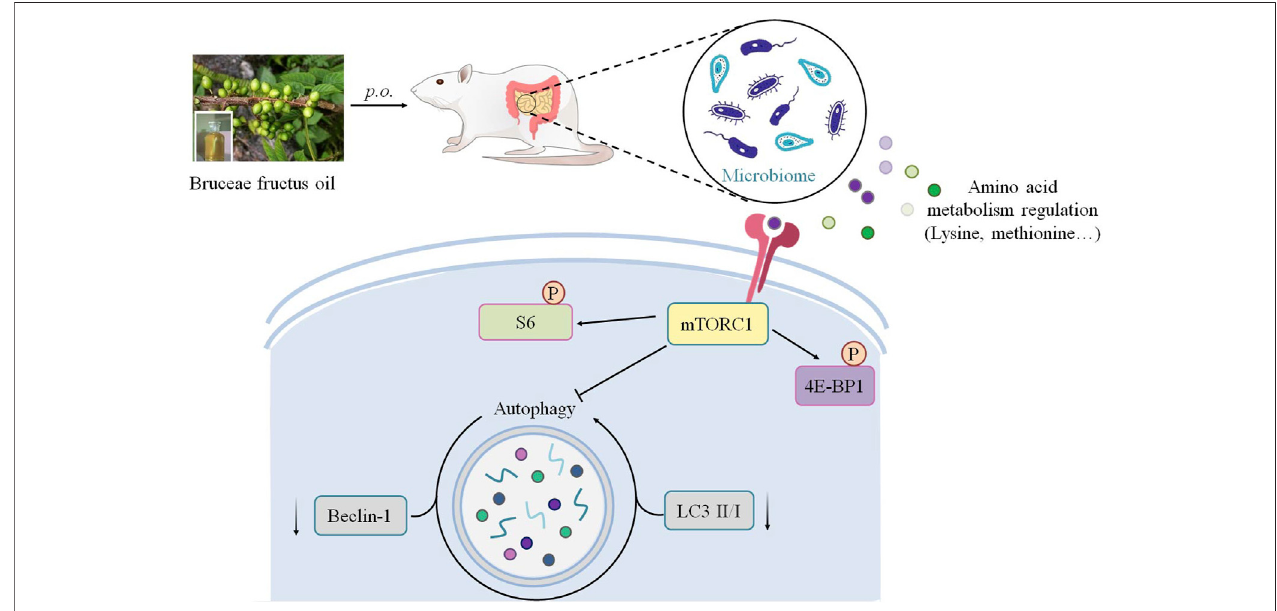
FIGURE 8 | Schematic illustration depicting the potential mechanism associated with the gut microbiota – dependent tumor suppression of BO on TNBC.